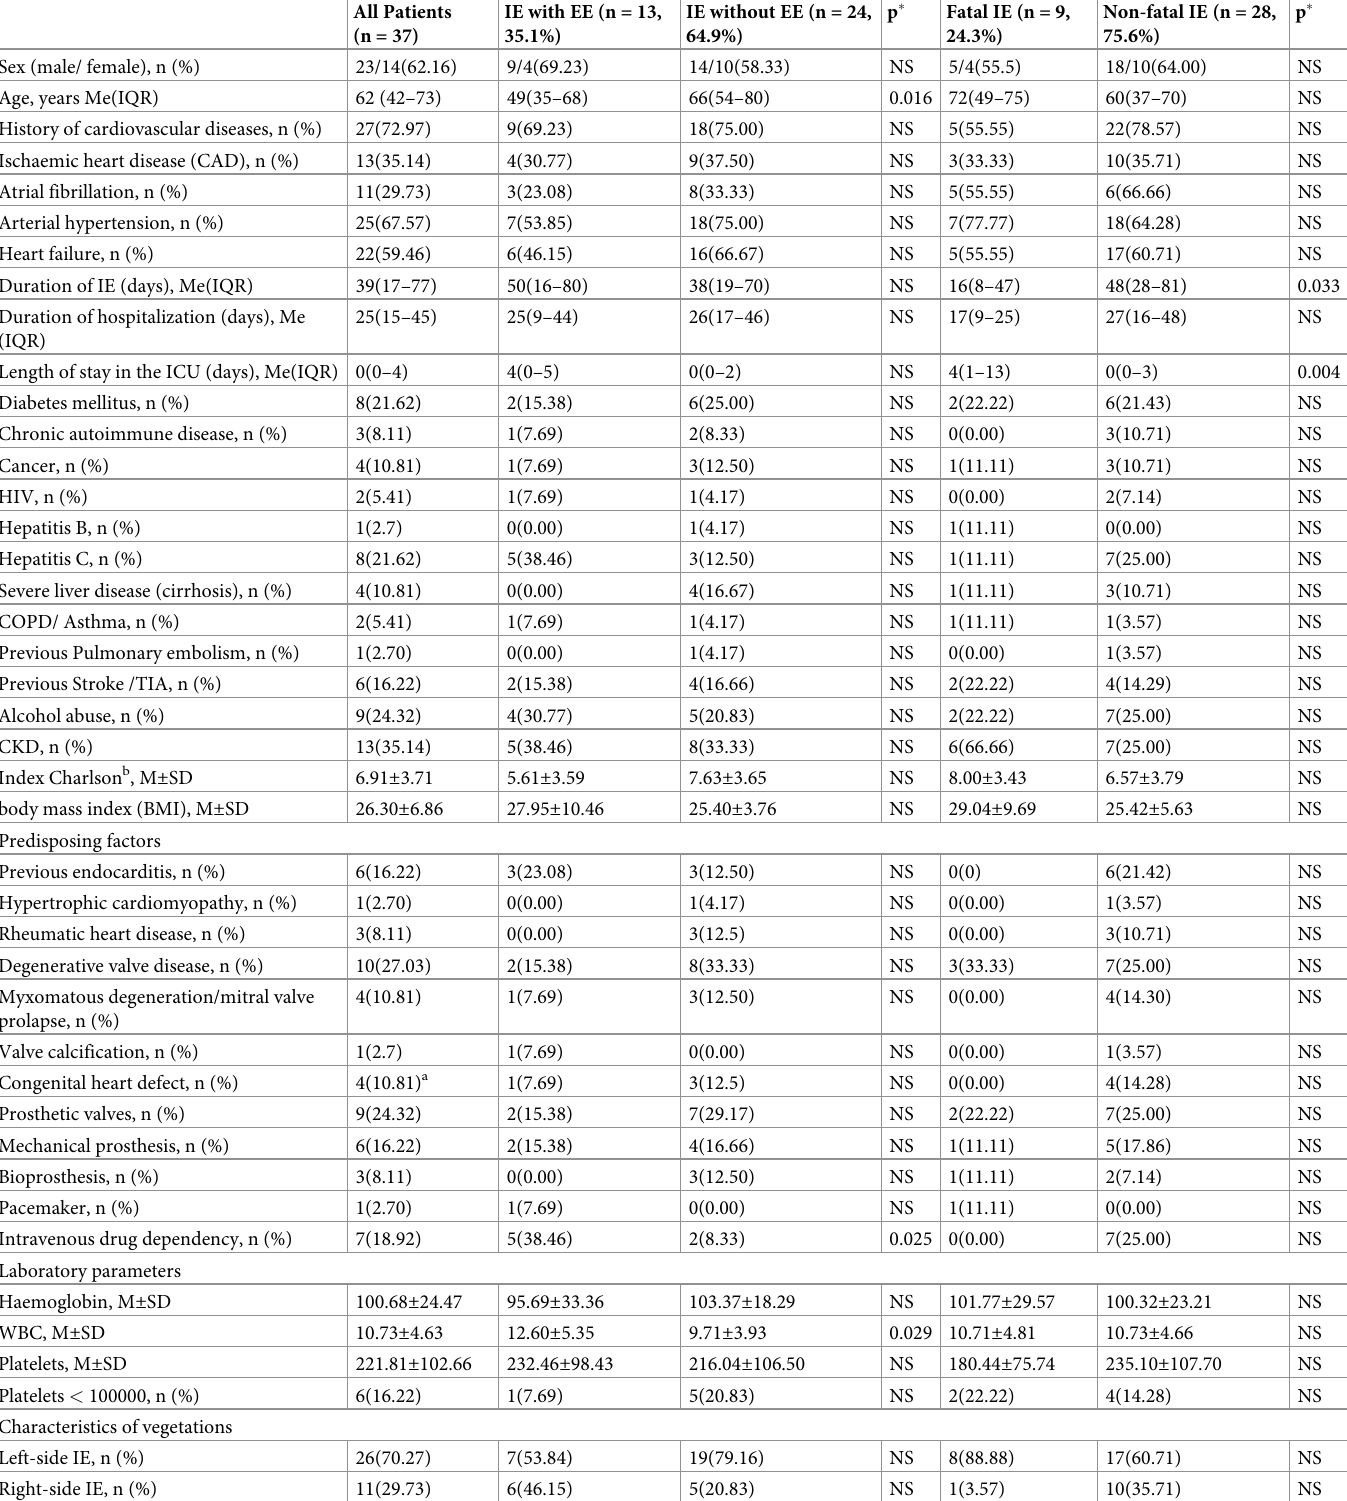
Table 2. Clinical characteristics of groups according to outcomes.